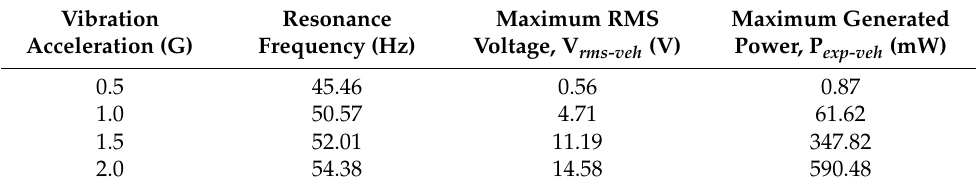
Table 5. Maximum generated power with a 360- Ω load resistance (P exp-veh ) at one lower coil of the magnetic spring vibration-energy-harvesting device. The maximum moving displacement of the spring was 7